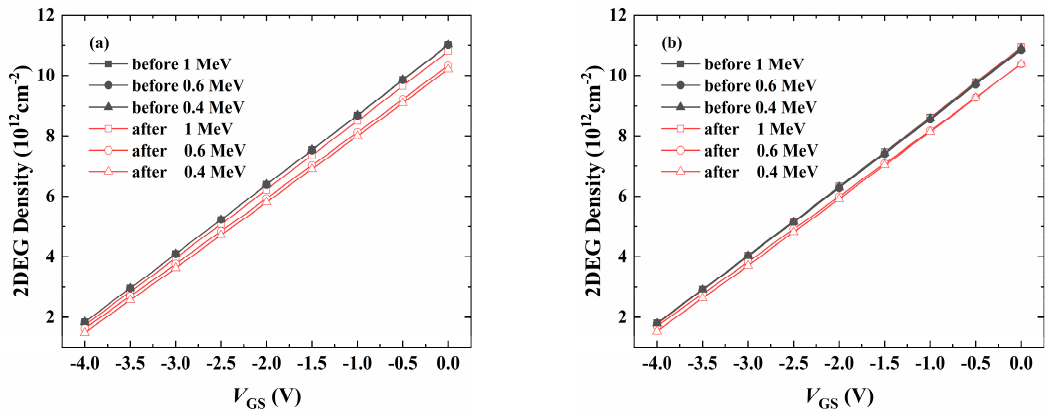
Figure 3. Gate–channel 2DEG electron density n 2D as a function of gate voltage for Device 1 ( a ) and Device 2 ( b ).